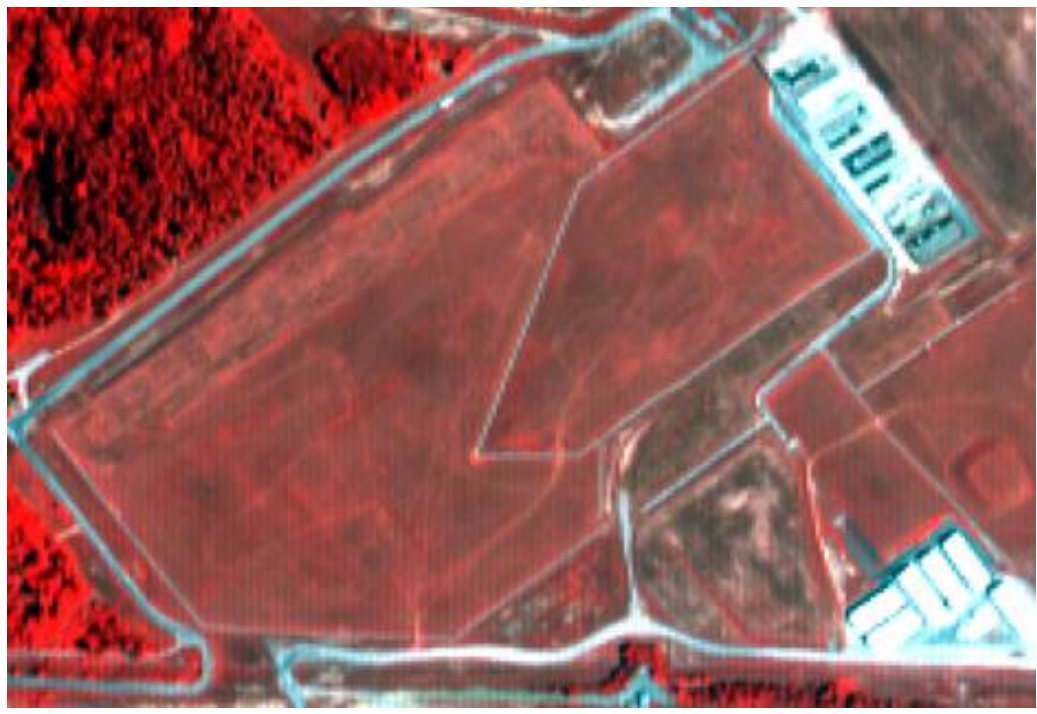
Figure 9. Airborne hyperspectral image of the clay-capped Mixed Waste Management Facility at the Savannah River Site obtained on July 22, 2002 at a spatial resolution of 2 × 2 m. Spectral analysis of the bands can locate potential areas of failure of the facility. Subsequent images can be used for change detection from Jensen [60] and